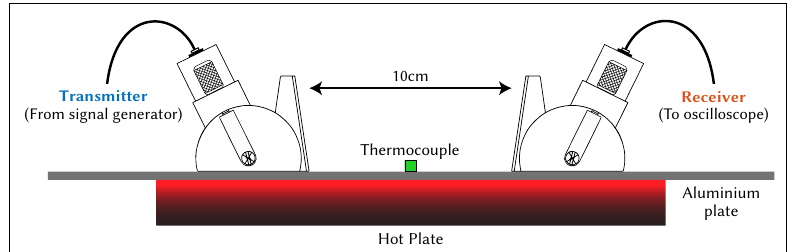
Figure 7. Cross-sectional diagram of total time-of-flight measurement setup.